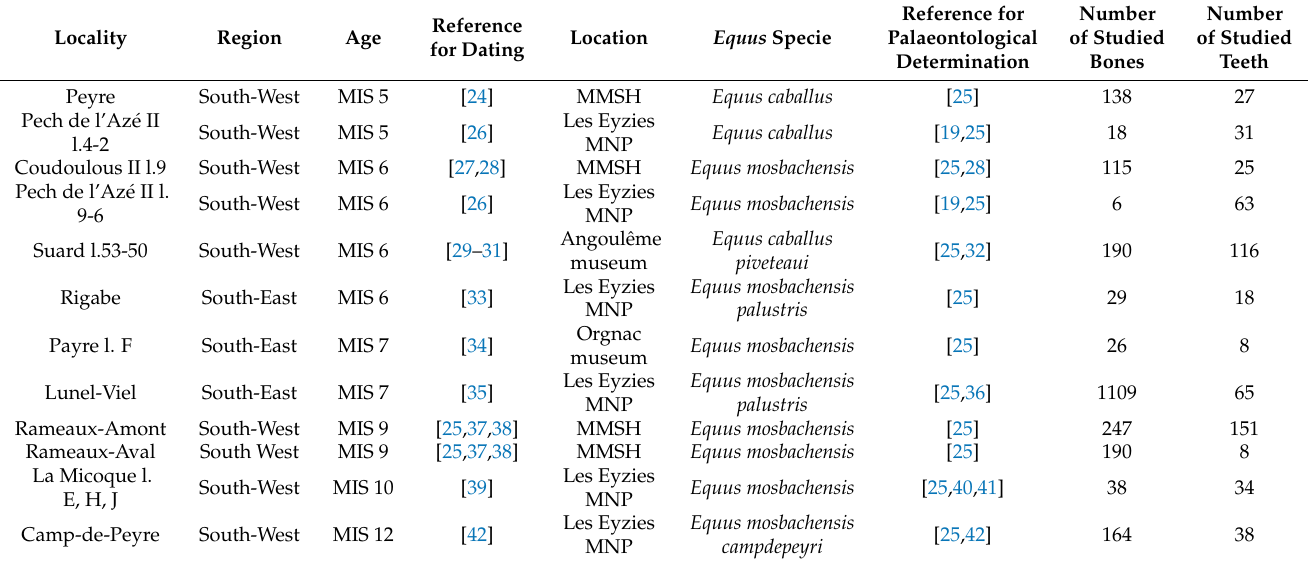
Rameaux-Aval South West